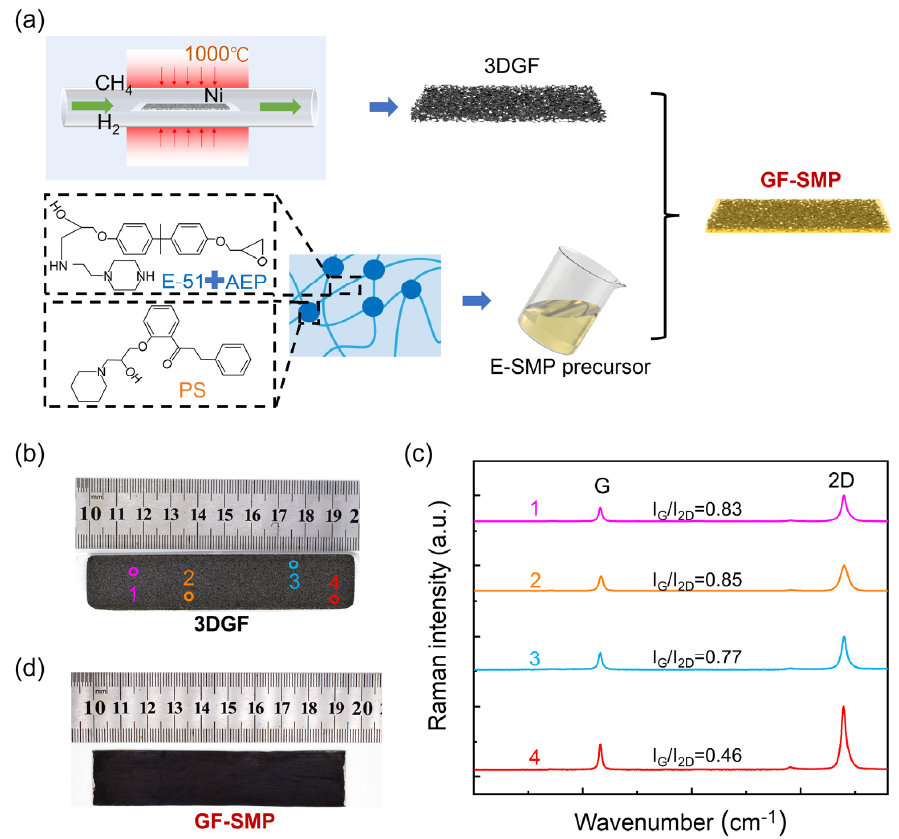
Figure 1. ( a ) Synthetic procedure for GF-SMP, ( b ) Image of a graphene foam sample, ( c ) Raman spectra of the graphene foam, ( d ) Image of a GF-SMP sample.